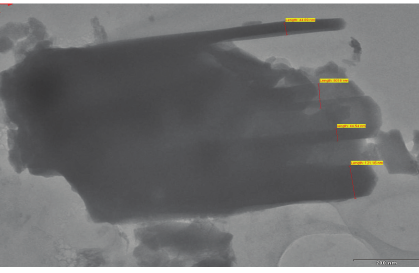
Figure 3: EDX spectra of 4% cobalt doped TiO 2 .